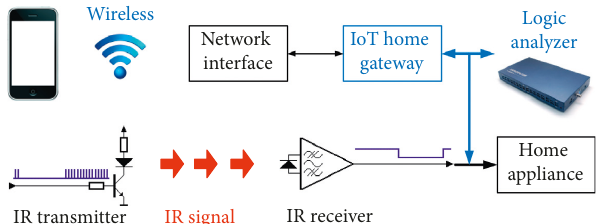
Figure 7: Application scenario.